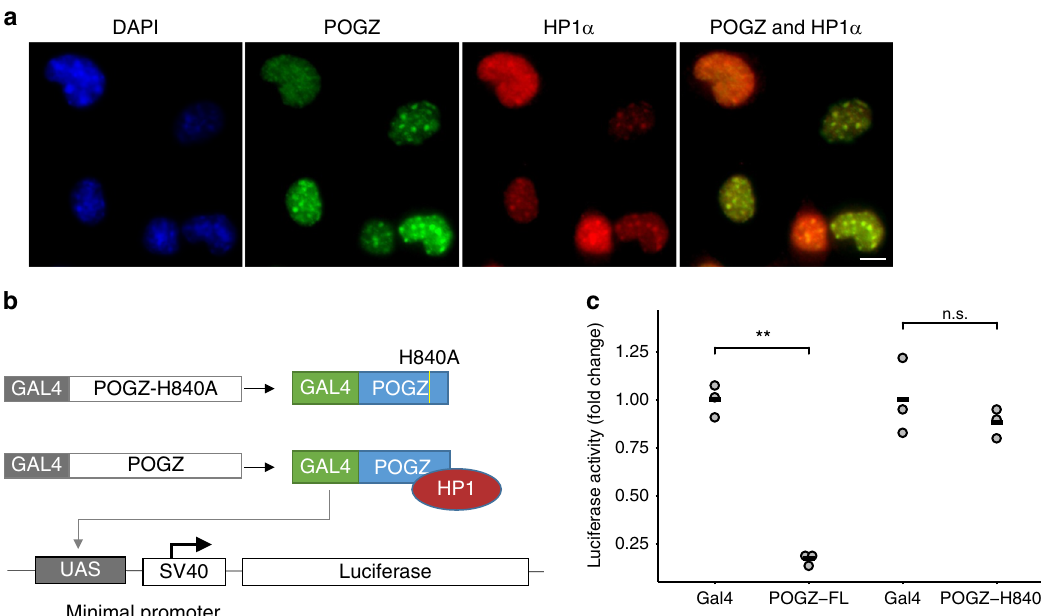
Fig. 4 POGZ localizes to pericentric chromatin and represses transcription depending on HPZ. a Immuno fl uorescence staining of mouse neuronal cells (N2A) using antibodies against POGZ (green), HP1 α (red), and DAPI (blue). Three replicates in one experiment. b Schematic representation (not to scale) of the GAL 4-fusion proteins and a reporter gene containing GAL4-binding sites (UAS) located upstream of the SV40 promoter and luciferase gene (UAS- SV40-luc). The H840A mutation, that change the conserved amino acid Histidine to Alanine in the HPZ motif, was previously shown to abolish the interaction between POGZ and HP1 α 25 . c Fold change of luciferase activity in HEK293 cells expressing: Gal4, Gal4 DNA binding domain (DBD) fused to full-length POGZ (POGZ -FL), or Gal4-DBD fused to POGZ with a mutation in the HPZ sequence (POGZ H840A). Three independent experiments for each condition. Two-tailed t test; ** P < 0.01; n.s. not signi fi cant. The black horizontal line indicates the